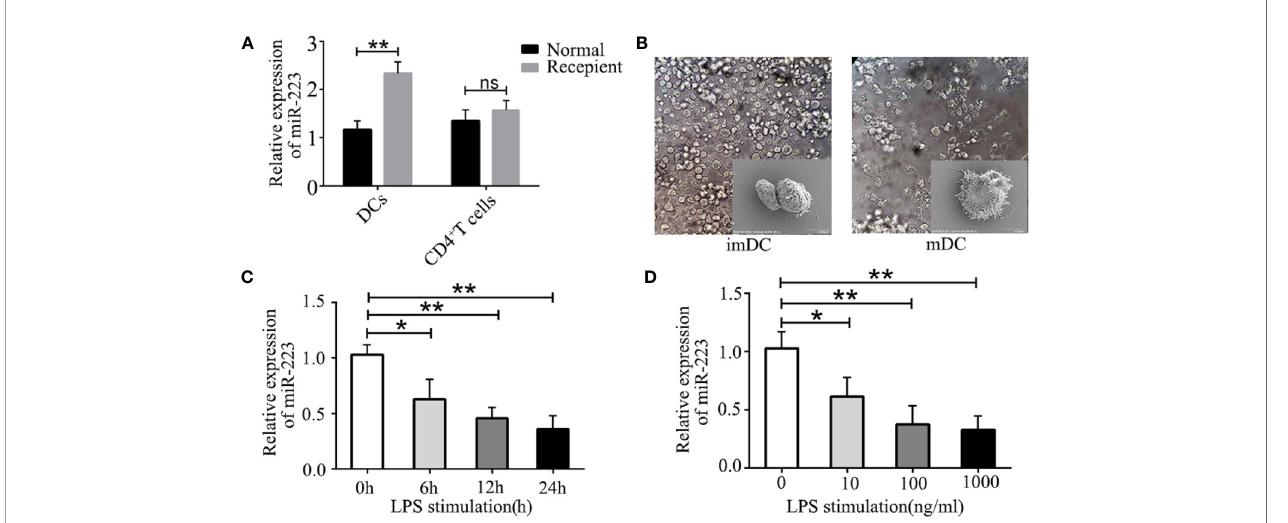
FIGURE 2 | Role of miR-223 in DC maturation. (A) Expression of miR-223 in DCs and CD4 + T cells from the spleens of normal and recipient mice. (B) Typical features of imBMDCs and mBMDCs. (C, D) miR-223 expression in BMDCs stimulated with LPS (100 ng/ml) for the indicated times (C) or with the indicated concentration of LPS for 12 h (D) . Data are presented as mean ± SD and represent three experiments. *P < 0.05; **P < 0.01; ns, not signi fi